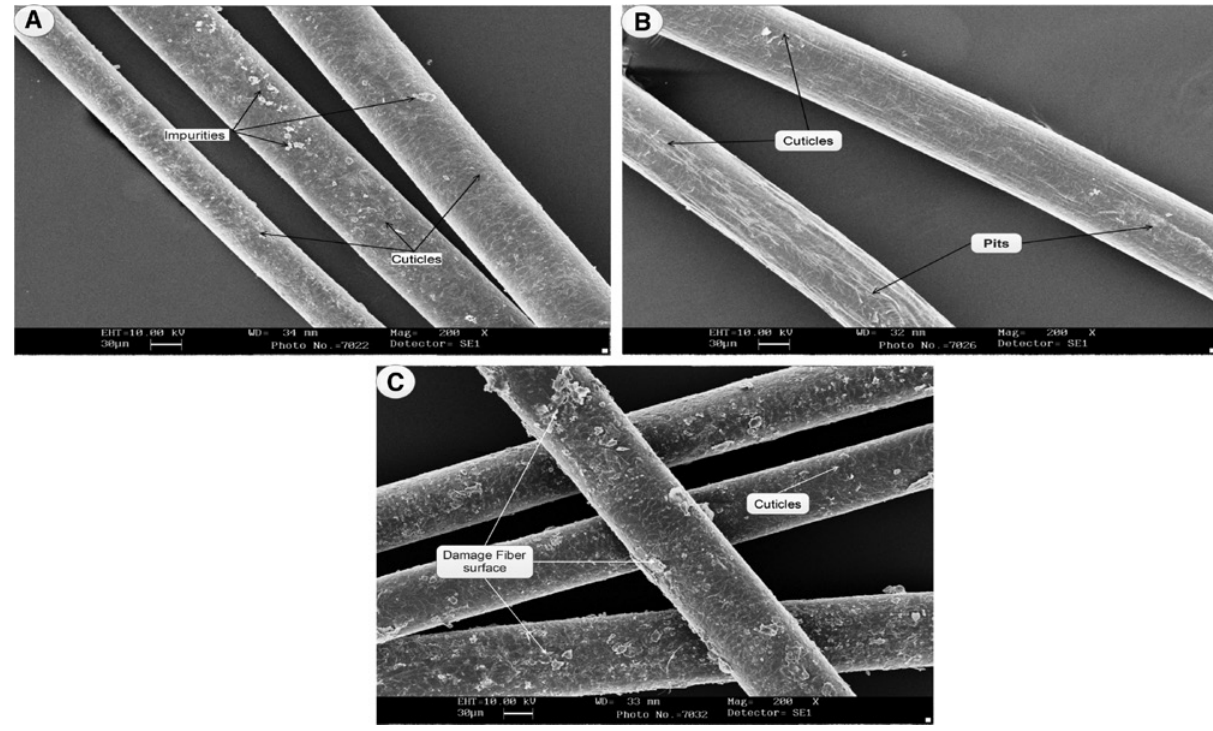
Figure 2: Morphology of the untreated, 0.25 N alkali treatment (AT and 0.5 N AT HFs). (A) SEM micrographs of untreated HF. (B) SEM micrographs of 0.25-N AT HF. (C) SEM micrographs of 0.5-N AT